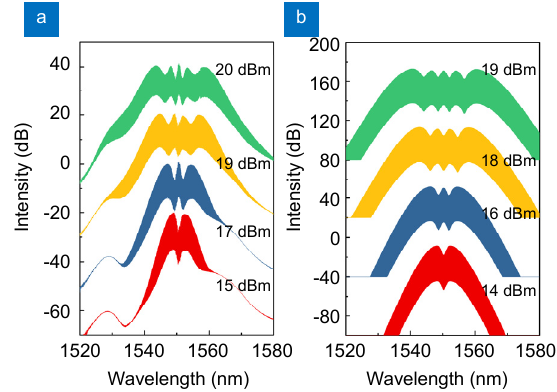
Fig. 2 | Optical spectra after propagation in 500 m HNLF. ( a ) The experimental results when the input optical power into the HNLF is 15 dBm, 17 dBm, 19 dBm, 20 dBm, respectively. ( b ) The simulation results when the input optical power is 14 dBm, 16 dBm, 18 dBm, 19 dBm, respectively.